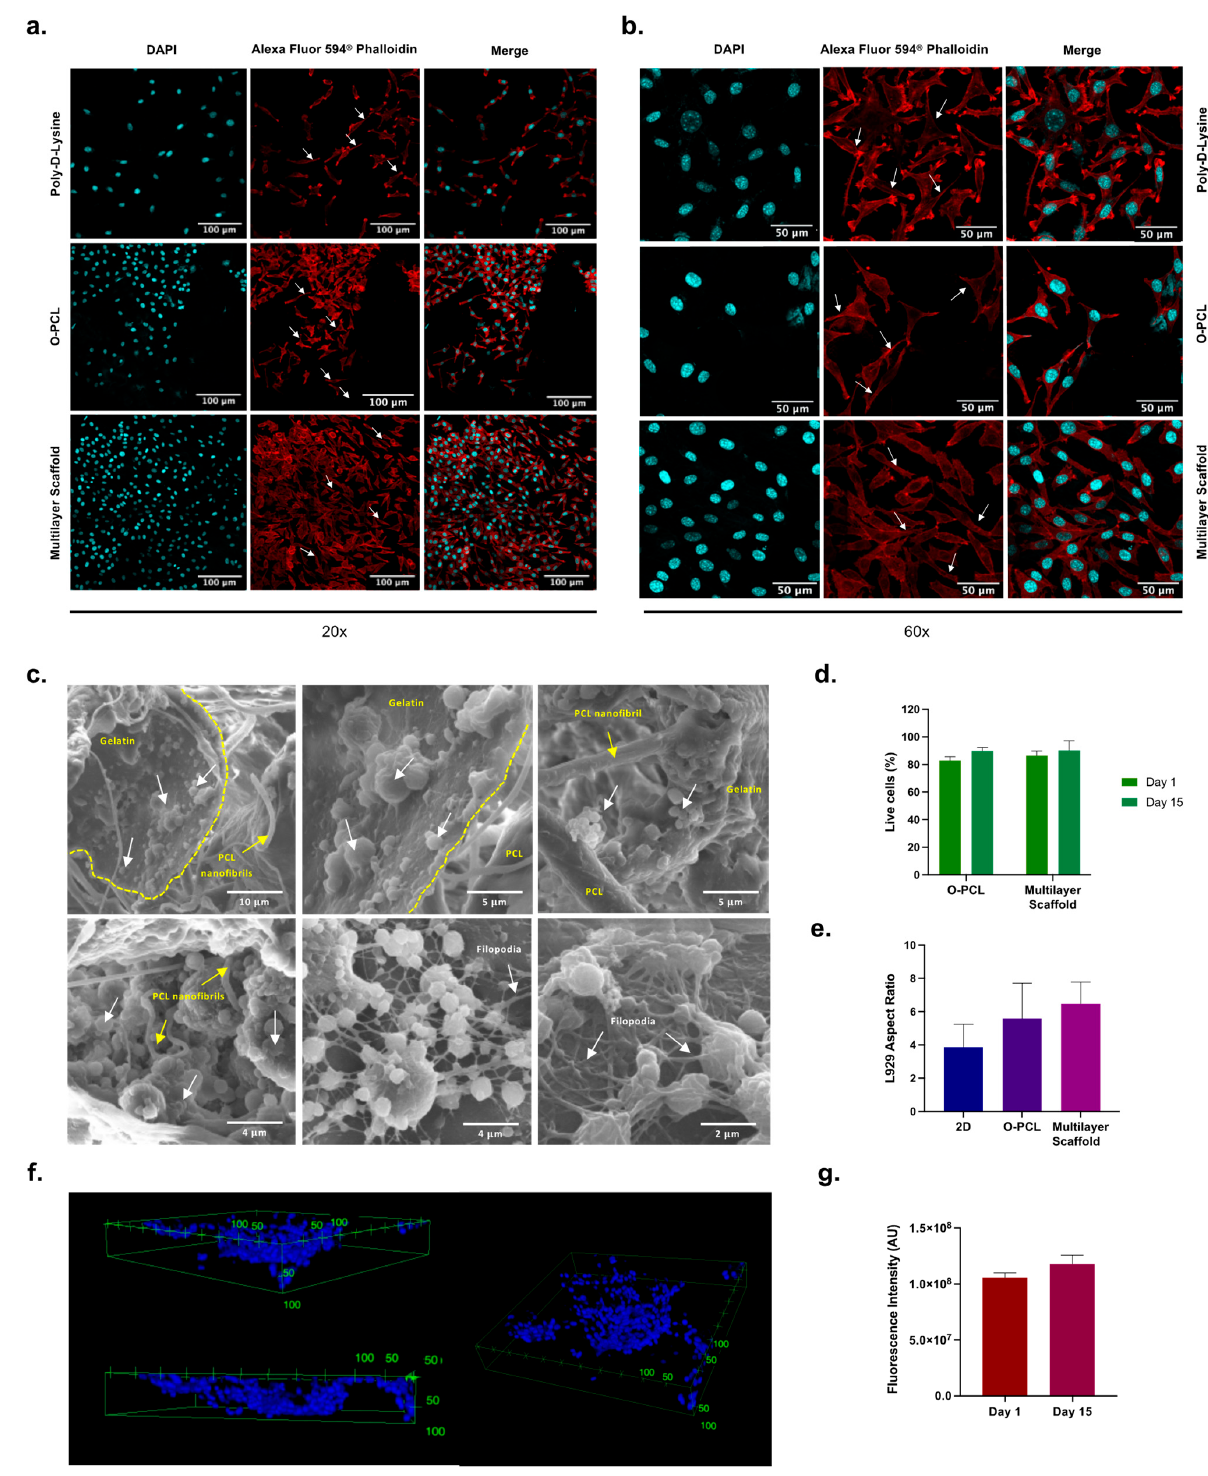
Figure 7. Cellular response upon after 15 days of culture. F-actin and DAPI stained L929 mouse fibroblasts at 20 × magnification ( a ) and 60 × magnification ( b ). White arrows point to the spindle-like morphology achieved by seeded cells. ( c ) SEM inspection of the cell seeded cryofractured samples. White arrows point to cell clusters and filopodia. ( d ) Live/dead analysis. ( e ) Aspect ratio (AR) of L2929 after 15 days of cell culture. ( f ) Cell nuclei distribution as reconstructed from confocal Z-stacks. Reference dimensions are shown in micrometers. ( g ) DHE fluorescence intensity after 1 and 15 days of THP-1 culture.